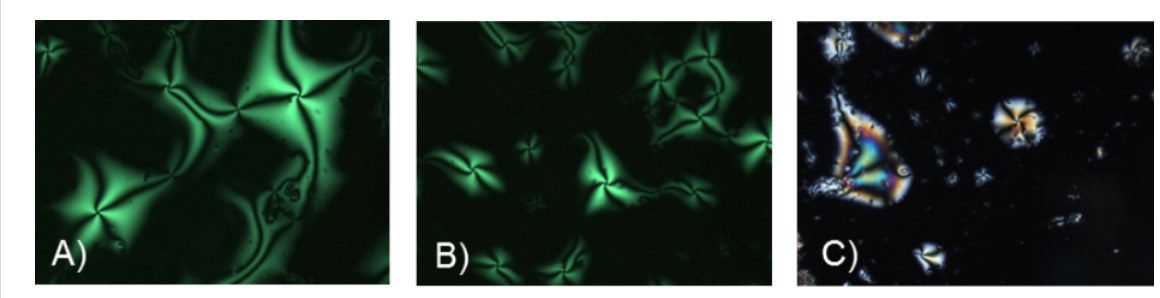
Figure 4: Schlieren textures of 13a and 13b under crossed polarizers upon cooling (cooling rate 5 K/min) from the isotropic liquid (magnification 200×): (A) 13b (61 °C), (B) 13b at 61 °C, different section, (C) 13a (46 °C).